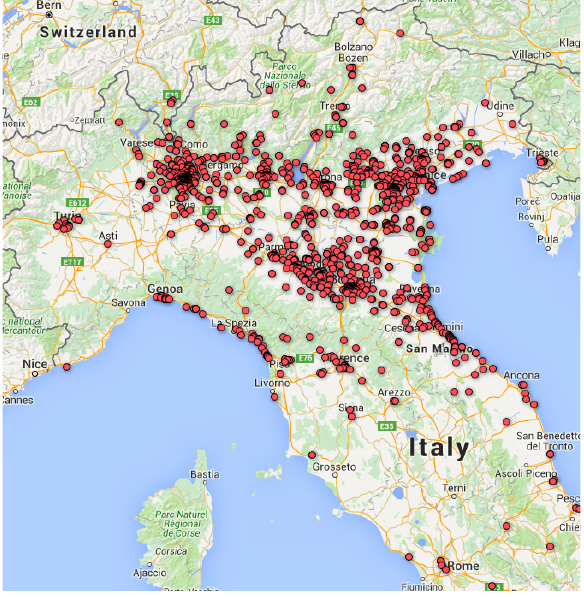
Figure 8. Tweets localization map: May 29, 2012, 7:00 a.m.-8:59 a.m. UTC (Google Fusion Table).